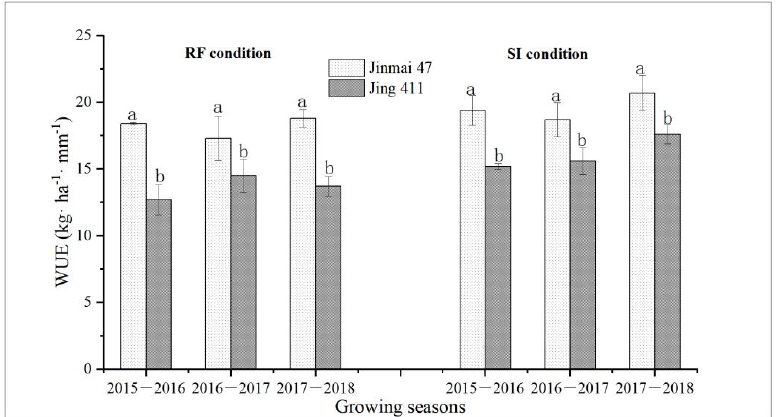
Figure 4. Grain yield of the genotypes Jinmai 47 and Jing 411 under rain-fed (RF) and supplemental irrigation (SI) conditions. For each growing season, different letters indicate significant differences between the two genotypes at p < 0.05 based on the LSD test. Vertical bars indicate the standard deviation.